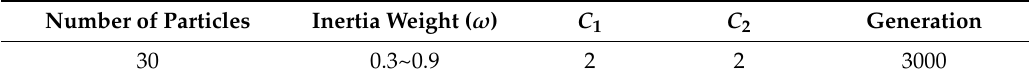
Table 1. Initial parameters of PSO.